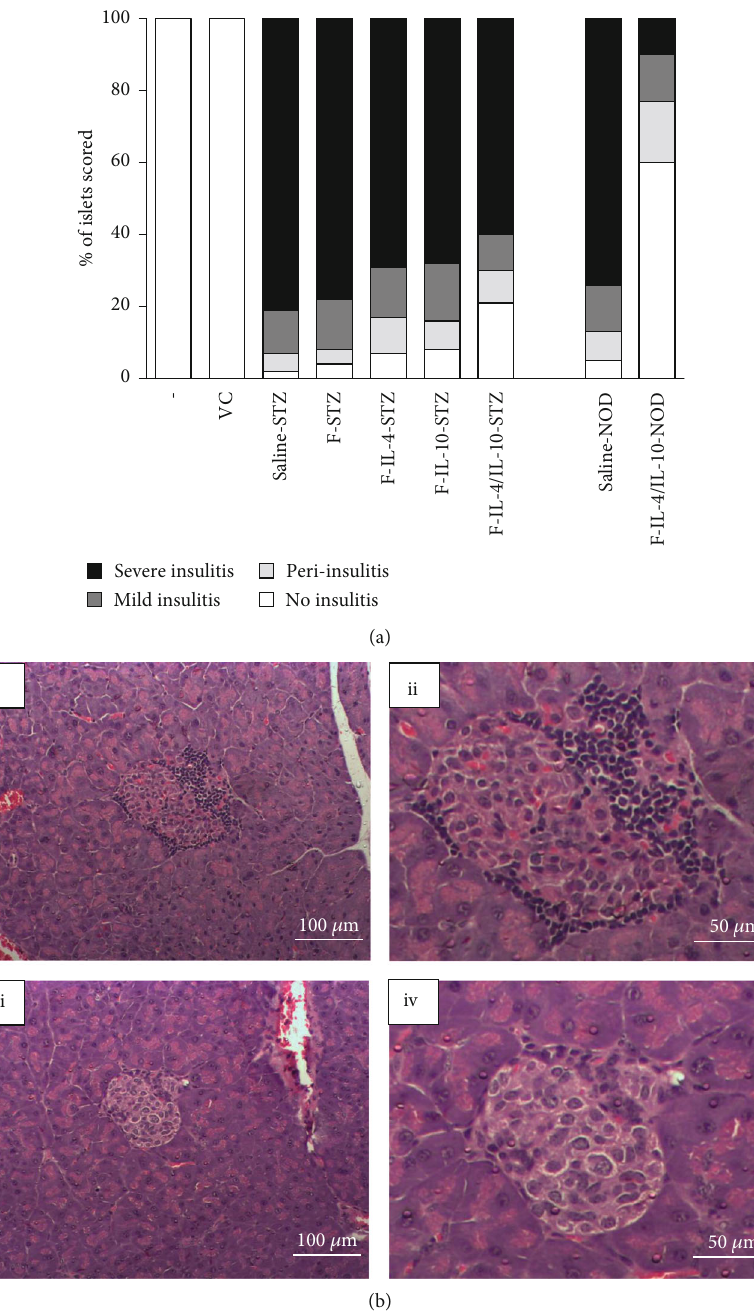
Figure 8: Combined administration of L. lactis MG1363 FnBPA + (pValac::dts:: IL-4 ) and L. lactis MG1363 FnBPA + (pValac:: IL-10 ) exerts protective e ff ects on pancreatic islets. (a) Insulitis scoring was performed in a blind manner on para ffi n-embedded pancreatic sections of STZ-induced mice and NOD mice at the end of experimental period. At least 15 islets were evaluated in each pancreatic sample. The data are shown as the mean of three independent experiments ( n = 6 ). (b) A representative pancreatic islet from the saline-NOD group (i-ii) and F-IL-4/IL-10-NOD group (iii-iv) is